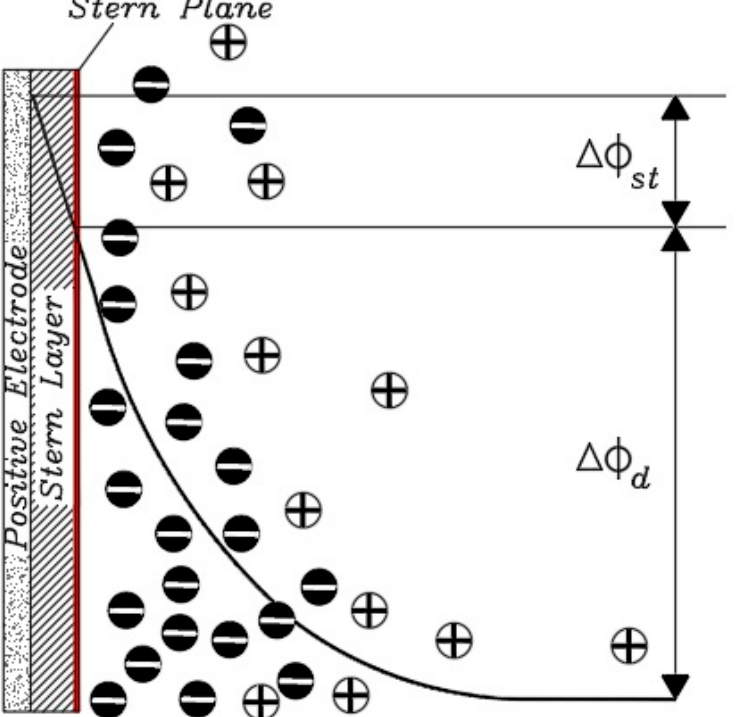
Figure 16. The potential difference in the Gouy-Chapman-Stern model in a non-overlapping porous space for the EDL.